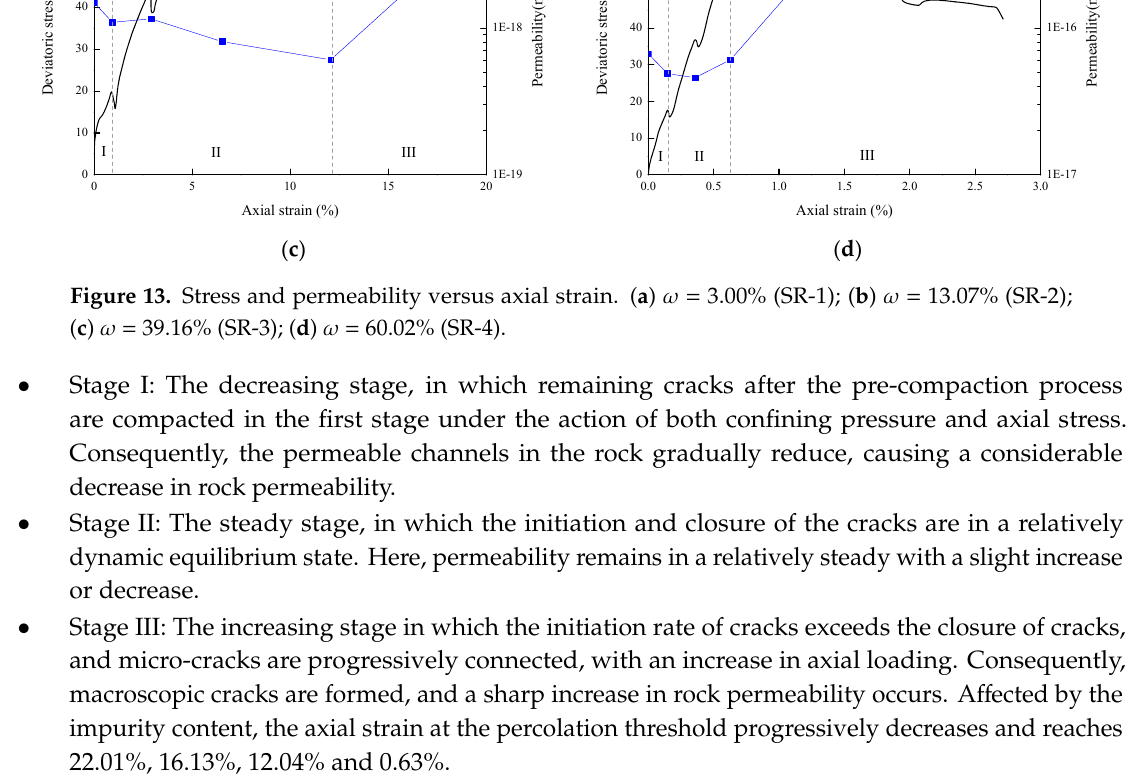
Figure 14. The permeability–stress ratio curves of the salt rocks with different impurity contents.